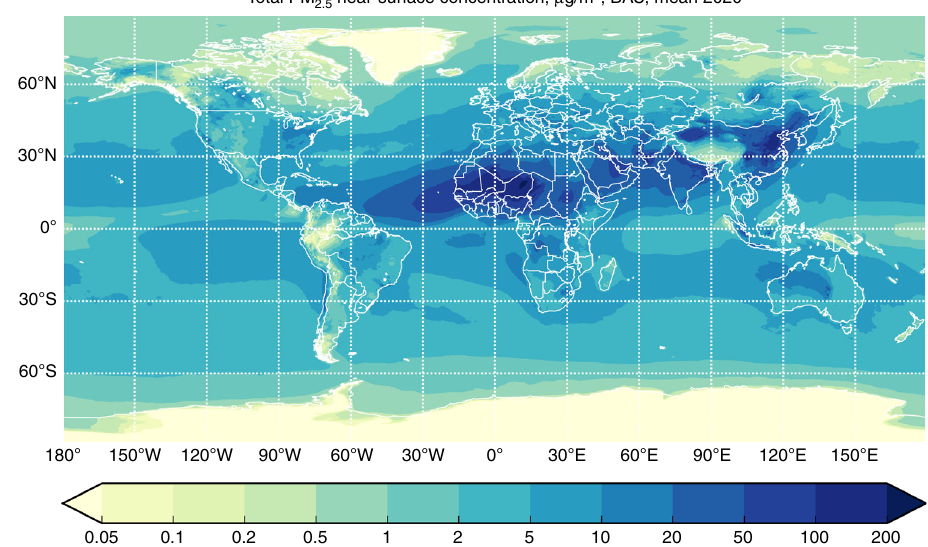
Fig. 1 Mean annual PM 2.5 concentrations from all sources. Model results showing mean annual PM 2.5 concentrations in micrograms per cubic meter from all sources and with business-as-usual ship emissions in 2020